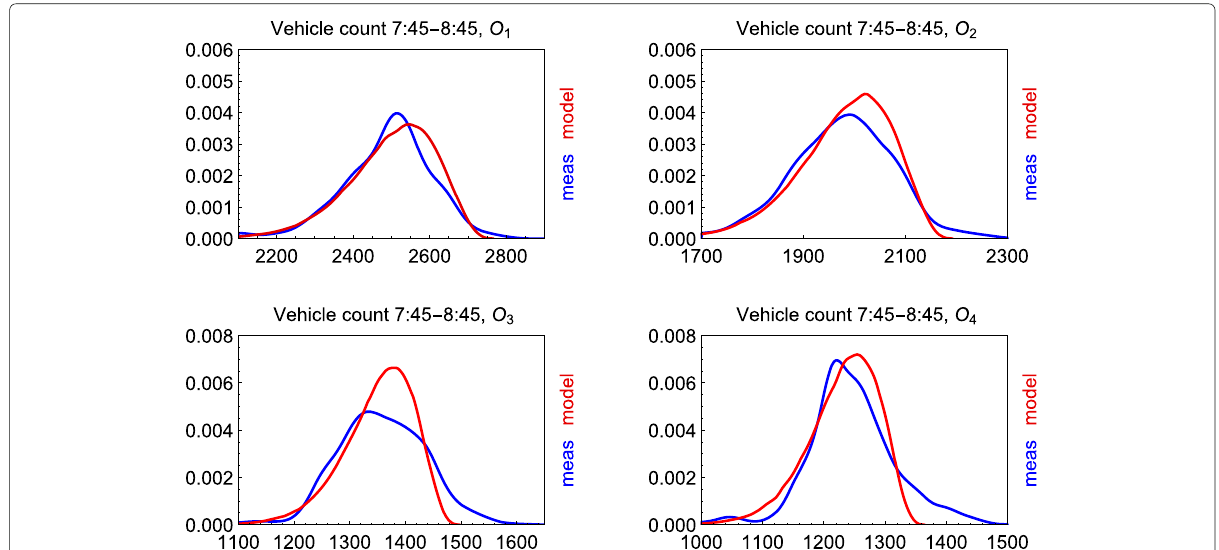
Fig. 6 Smooth histogram illustrations of measured (blue) and modelled (red) vehicle counts on Monday – Thursday mornings between 7:45 – 8:45 AM. A beta distribution has been taken to model γ